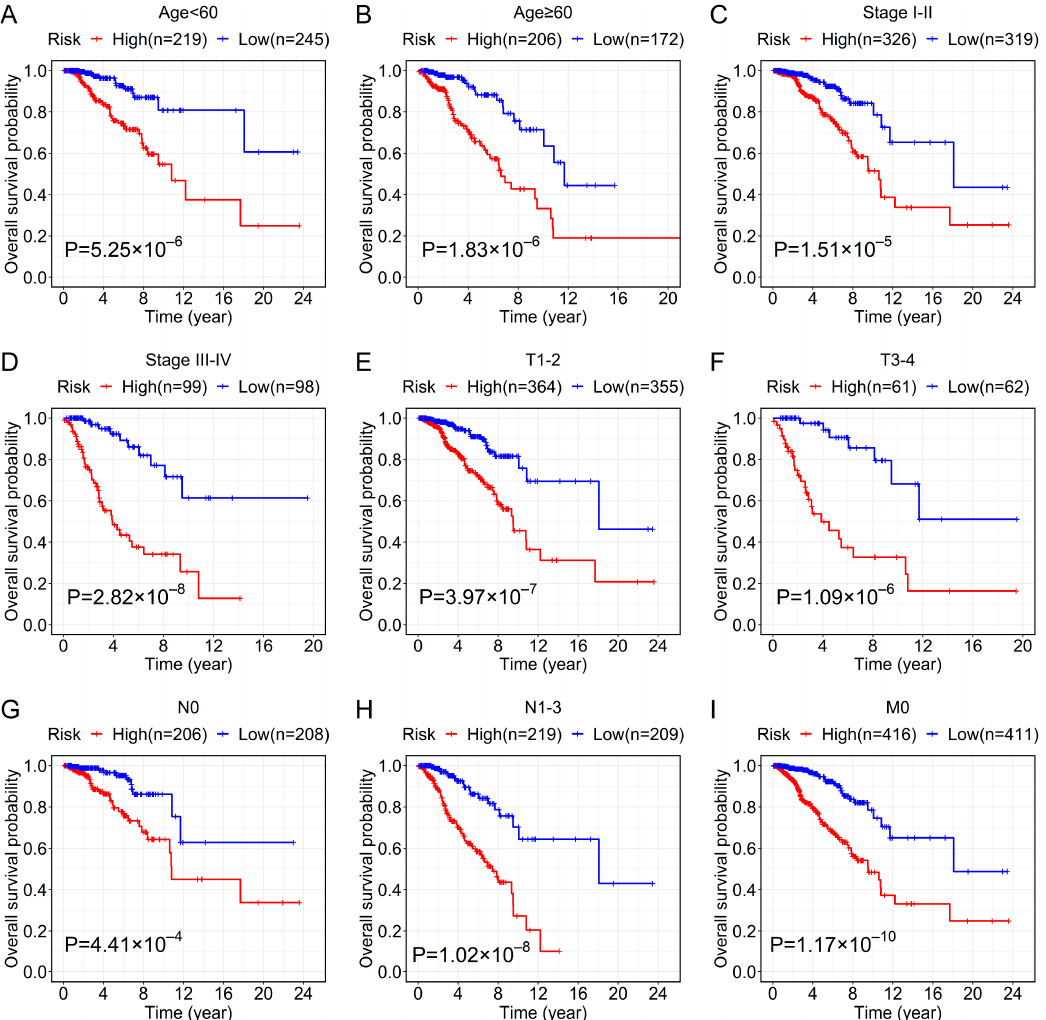
Figure 3. Kaplan–Meier survival analyses for BC patients of the high- and low-risk groups in the different clinical subgroups. The OS curve for BC patients of the high- and low-risk groups in the different subgroups stratified by clinical features based on the entire cohort, including age < 60 years old ( A ), age ≥ 60 years old ( B ), stage I–II ( C ), stage III–IV ( D ), T1–2 ( E ), T3–4 ( F ), N0 ( G ), N1–3 ( H ), and M0 ( I ).